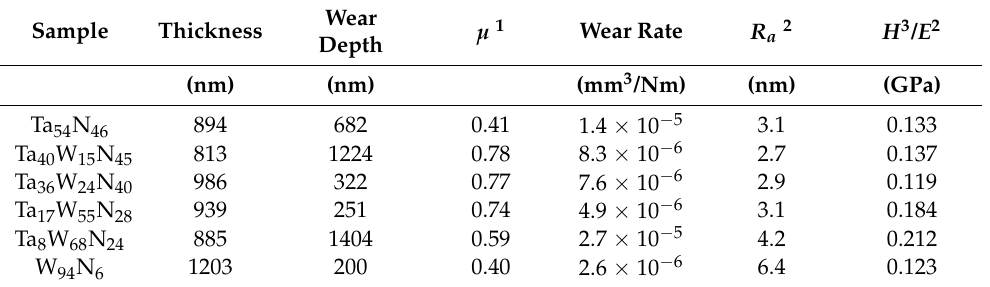
Table 4. Wear test results for the TaWN/Ta/SUS420 samples.